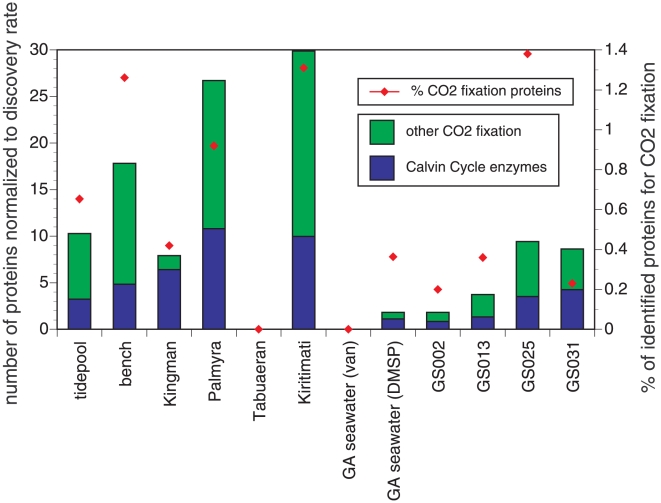
The number of proteins involved in CO2 fixation, including those of the Calvin-Benson cycle among a selection of marine metagenomes.To facilitate comparison among studies, the number of matches is normalized to the ‘discovery rate’ for proteins in the dataset (number of protein matches per 100 fragments). The point symbols represent the percent of all proteins identified that are used in CO2 fixation.